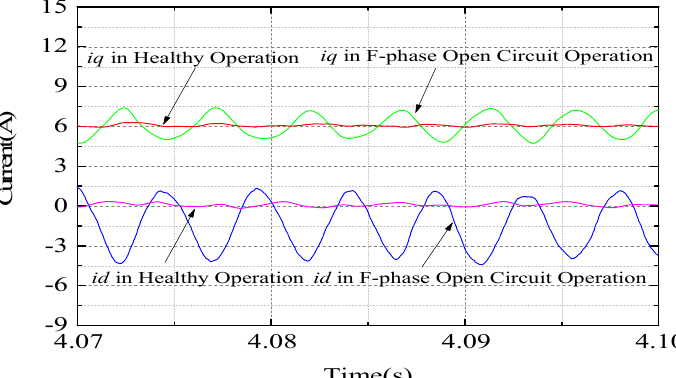
Figure 4. α-β subspace current trajectory. ( a ) Healthy motor. ( b ) F-phase open circuit. Figure 5 shows the dq subspace current of a healthy state and an open circuit fault state. It can be seen that the dq current of the motor is no longer stable in the open circuit fault, and the oscillation is severe.